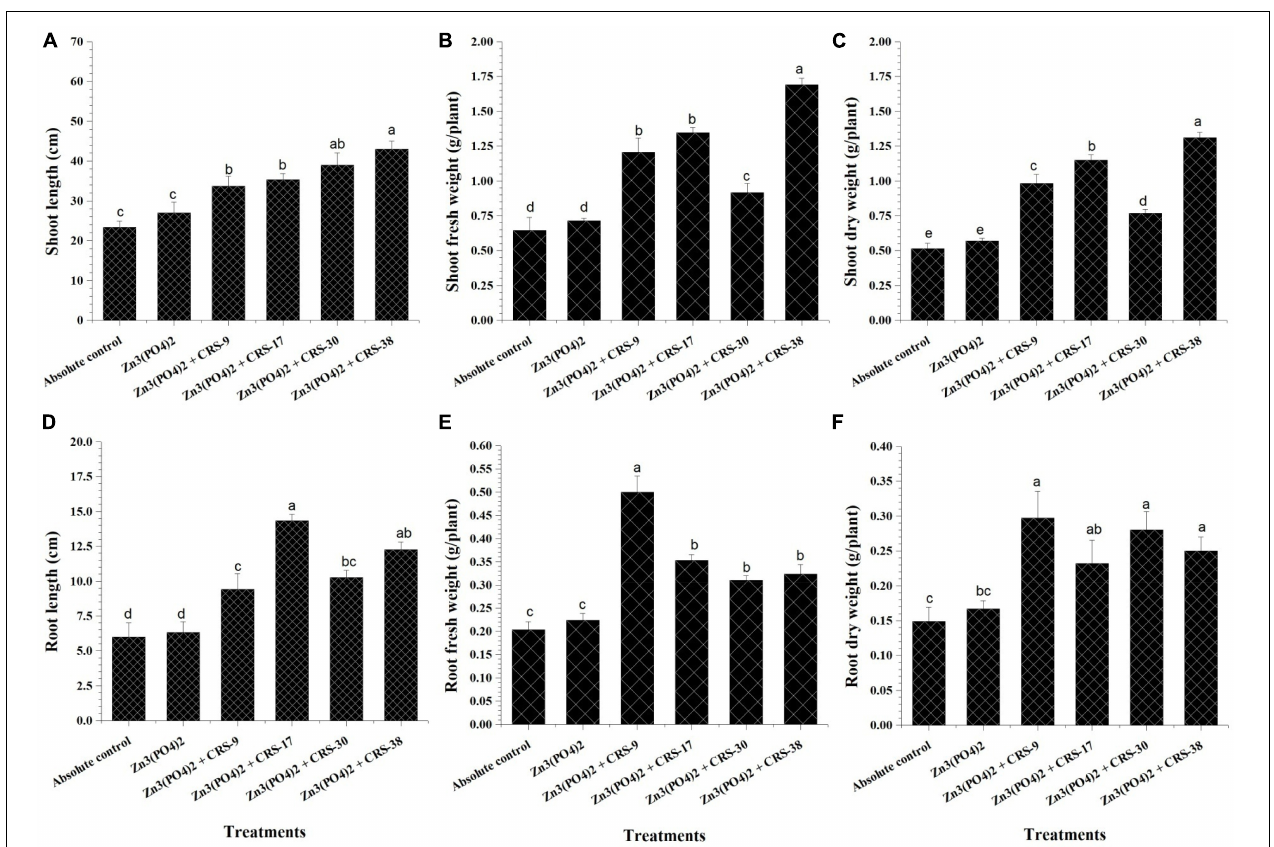
FIGURE 4 | Effect of zinc solubilizing rhizobacteria on growth parameters of plants harvested after 30 days (first set). (A) Shoot length, (B) Fresh weight of shoots (C) Dry weight of shoots, (D) Root length (E) Fresh weight of roots and (F) Dry weight of roots in comparison with absolute control. Data are mean ( n = 5) and vertical bar represents standard deviation. Data with different letters show significant difference in column data in randomized block design test at p < 0.05 under Duncan’s multiple range